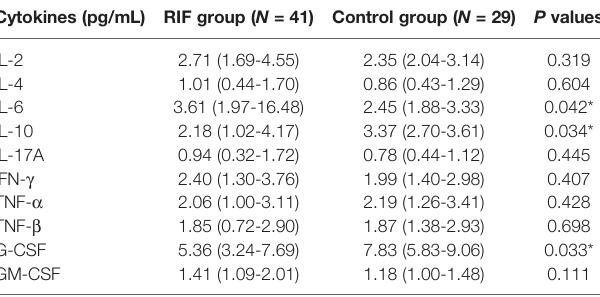
FIGURE 1 | Cytokine pro fi le screening with heatmap and PCA. Heatmap and PCA of 10 cytokine pro fi les in serum. Each row in the heatmap represents an individual differentially expressed cytokine, and the column displays the sample number. Cytokines with lower levels are displayed in green, while cytokines with higher levels are displayed in red. The points in the PCA diagram represent the samples, red for the control group and blue for the RIF group. The arrows represent the contribution and correlation of the corresponding original variables to the principal component. TABLE 3 | Serum cytokine pro fi les in the mid-luteal phase.